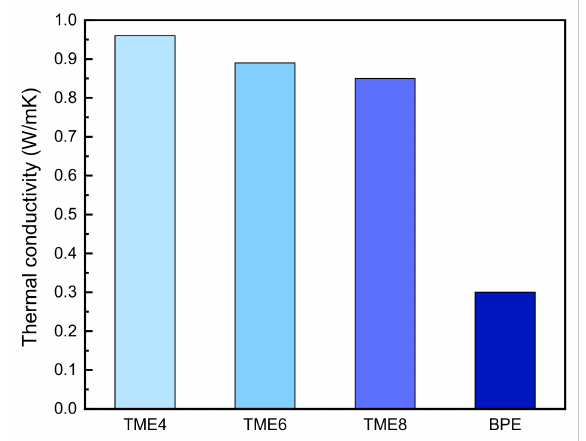
Figure 6. Thermal conductivities of TME n ( n = 4, 6, 8) and